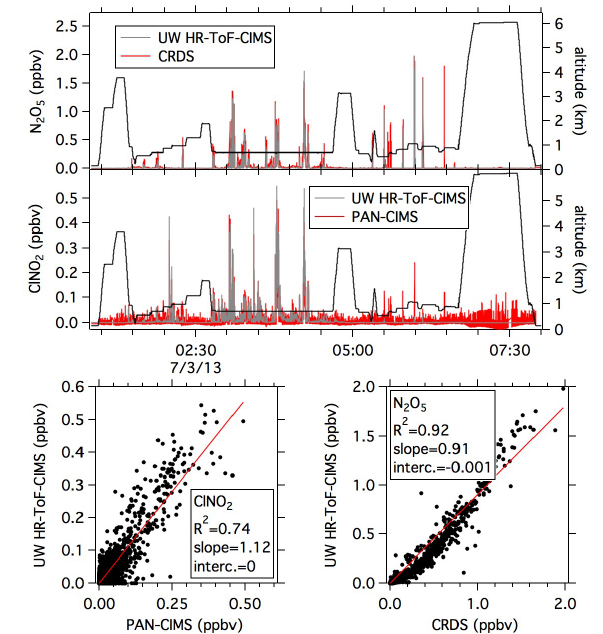
Figure 6. Inter-comparison between the UW HR-ToF-CIMS of N 2 O 5 with CRDS and ClNO 2 with the PAN-CIMS as time series and scatter plots for the nighttime flight on 3 July 2013.